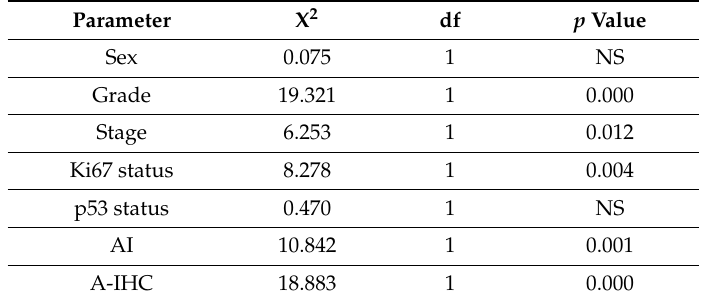
Table 3. Prognostic parameters examined in gastric tubular adenocarcinomas: A univariate analysis of cancer-specific mortality using the Mantel-Cox log-rank test.